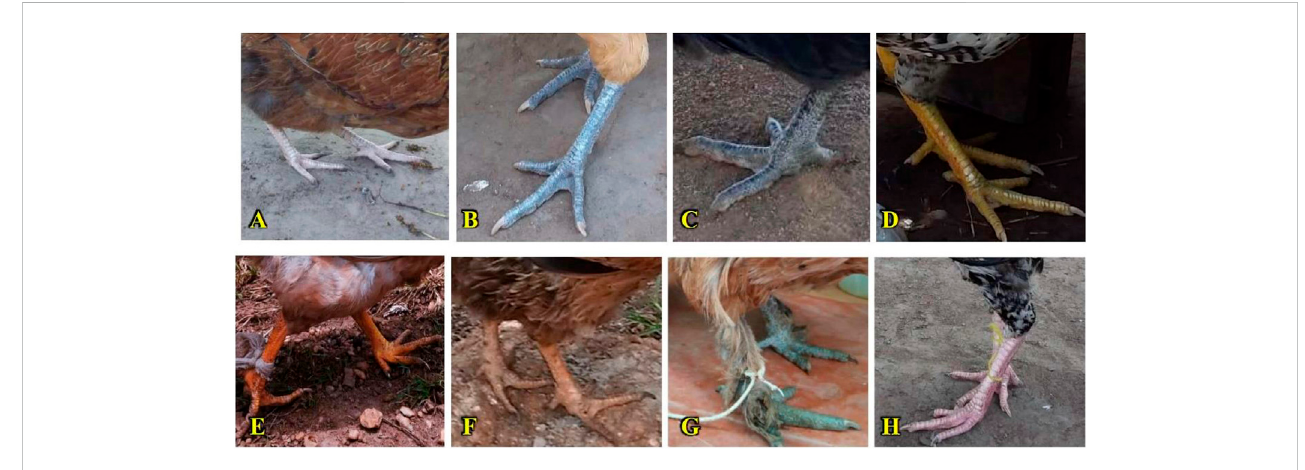
FIGURE 6 Shank (tarsus) colours. (A) White. (B) Grey/blue-grey. (C) Black/dark grey. (D) Yellow. (E) Orange. (F) Brown. (G) Green. (H)